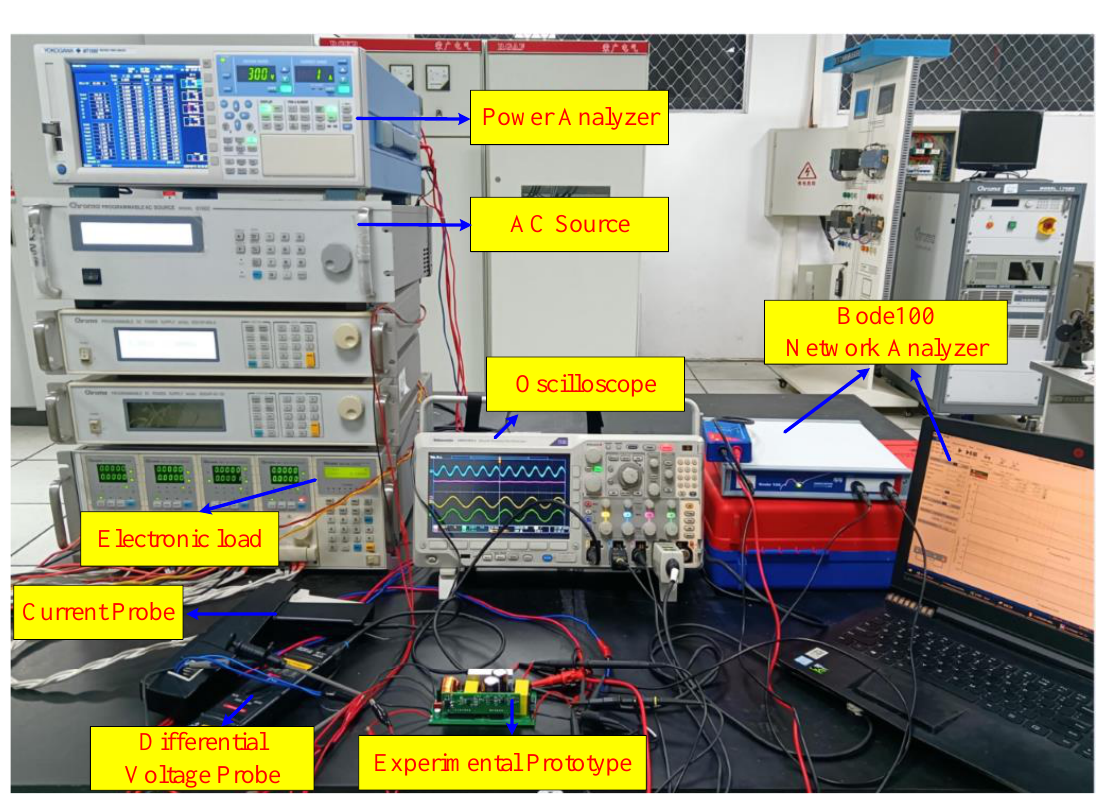
Figure 16. Experimental Platform . The experimental comparison waveforms, including input current, output voltage with 110 Vac and 220 Vac input voltage and rated load, are shown in Figure 18a–d. The experimental comparison waveforms with 0.1 A and 0.5 A output load and 110 Vac